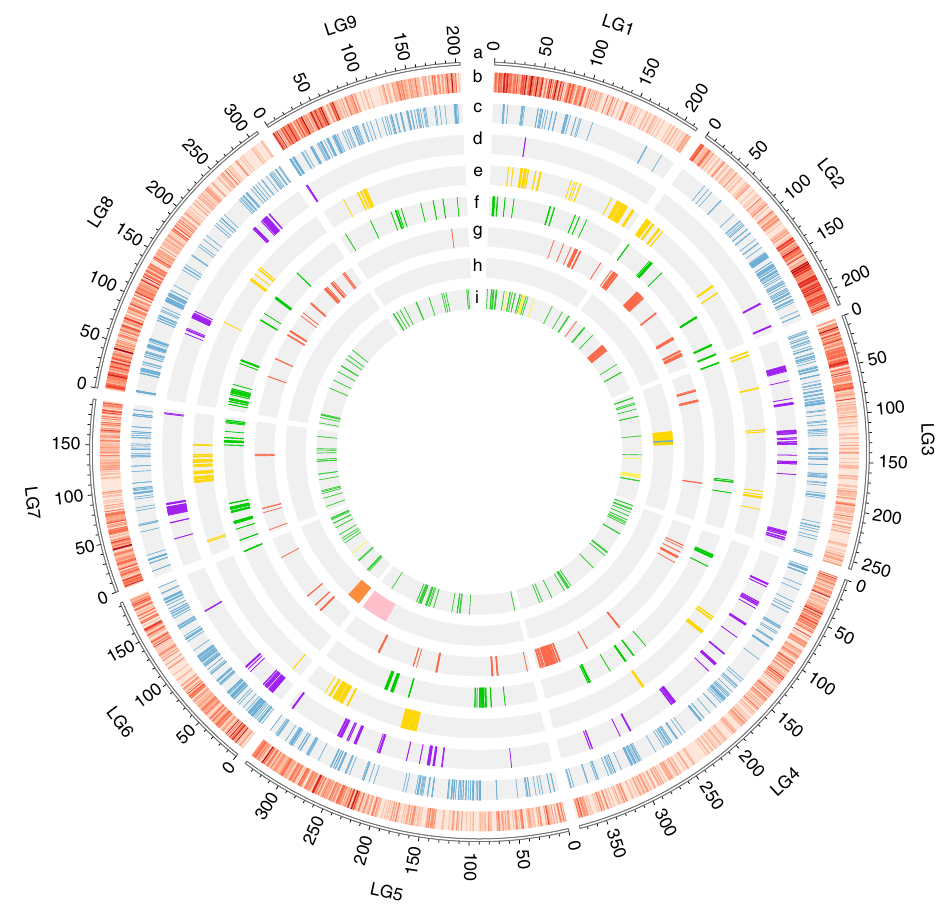
Fig. 3 Integrated results of selection and introgression analysis. a Nine chromosomes of lettuce. b Density of identi fi ed SNP in a 1 Mb window across the genome. c – g Selected regions in cultivated lettuce, butterhead, crisphead, romaine, and stem. h QTL mapping results for leaf-heading (yellow), lobed leaf (blue), stem spines (pink), and seed shattering (orange). i Introgressed regions from L. serriola (green), L. saligna (yellow), and L. virosa (red) in